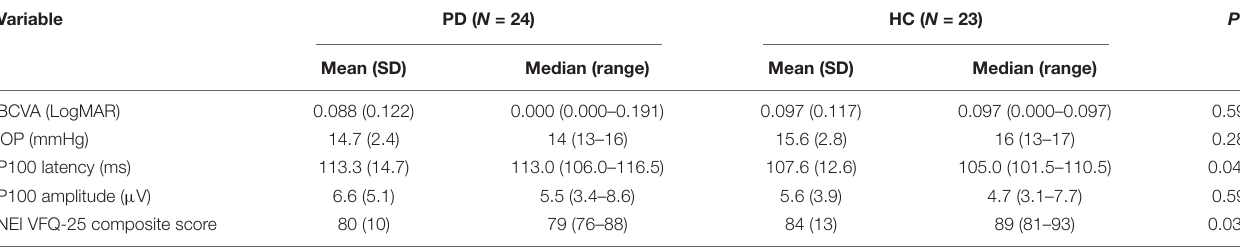
TABLE 2 | Ophthalmologic and VEP information of all enrolled participants.